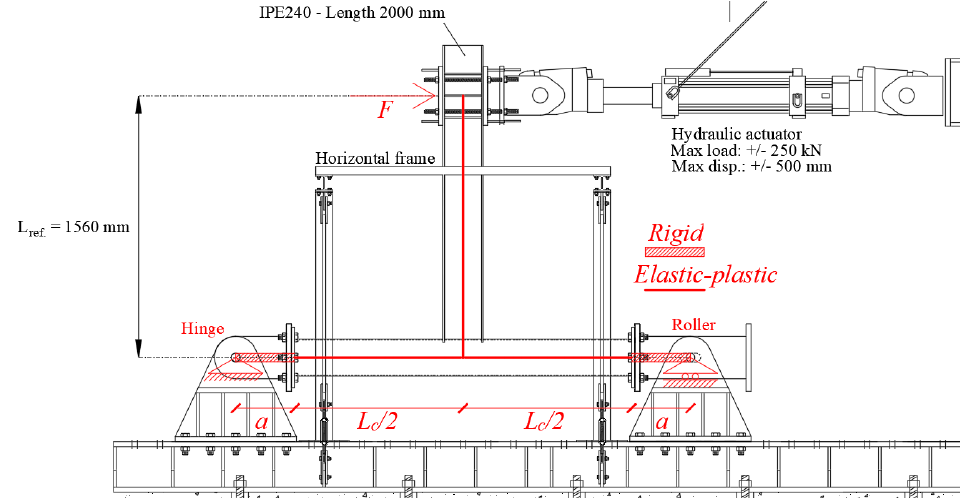
Figure 7. Structural scheme referring to which Equation (3) has been derived (adapted from [51]).